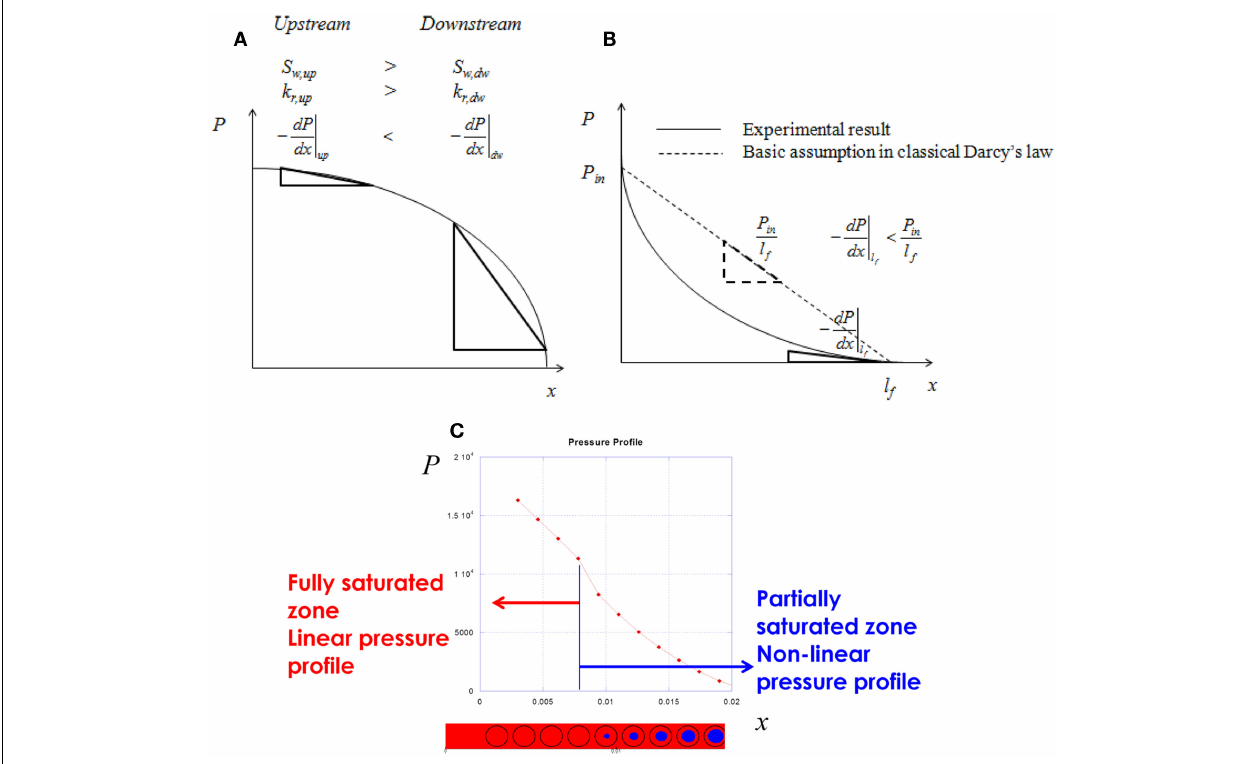
FIGURE 1 | Comparison of pressure gradient between the conventional modeling approach (relative permeability) and the experimental/simulation result . (A) Conventional modeling result by relative permeability approach in terms of degree of saturation (non-linear profile with negative curvature). (B) Experimental result of pressure gradient in the unsaturated flow (non-linear profile with positive curvature). (C) Transient Stokes–Brinkman simulation result (Jung et al.,